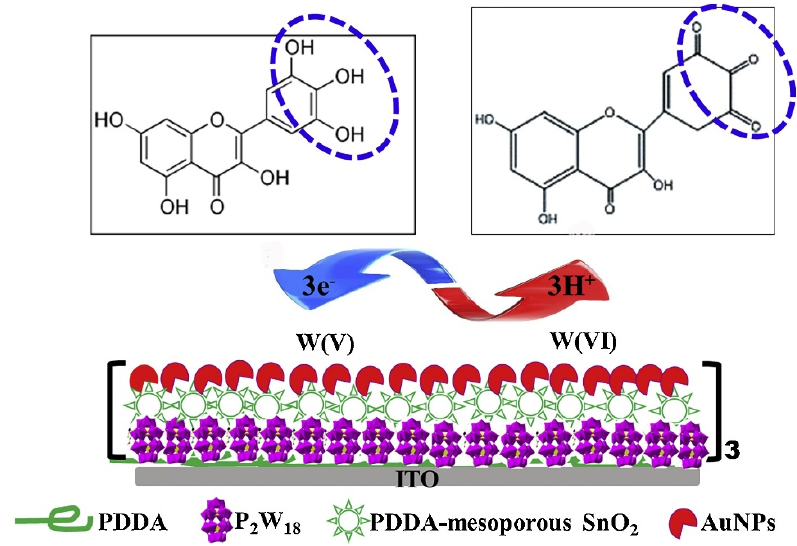
Figure 19. A schematic representation of the electrochemical oxidation of myricetin at the (P 2 W 18 -SnO 2 -AuNPs) 3 /ITO electrode. Reprinted with permission from [143]. Copyright 2019, Elsevier.